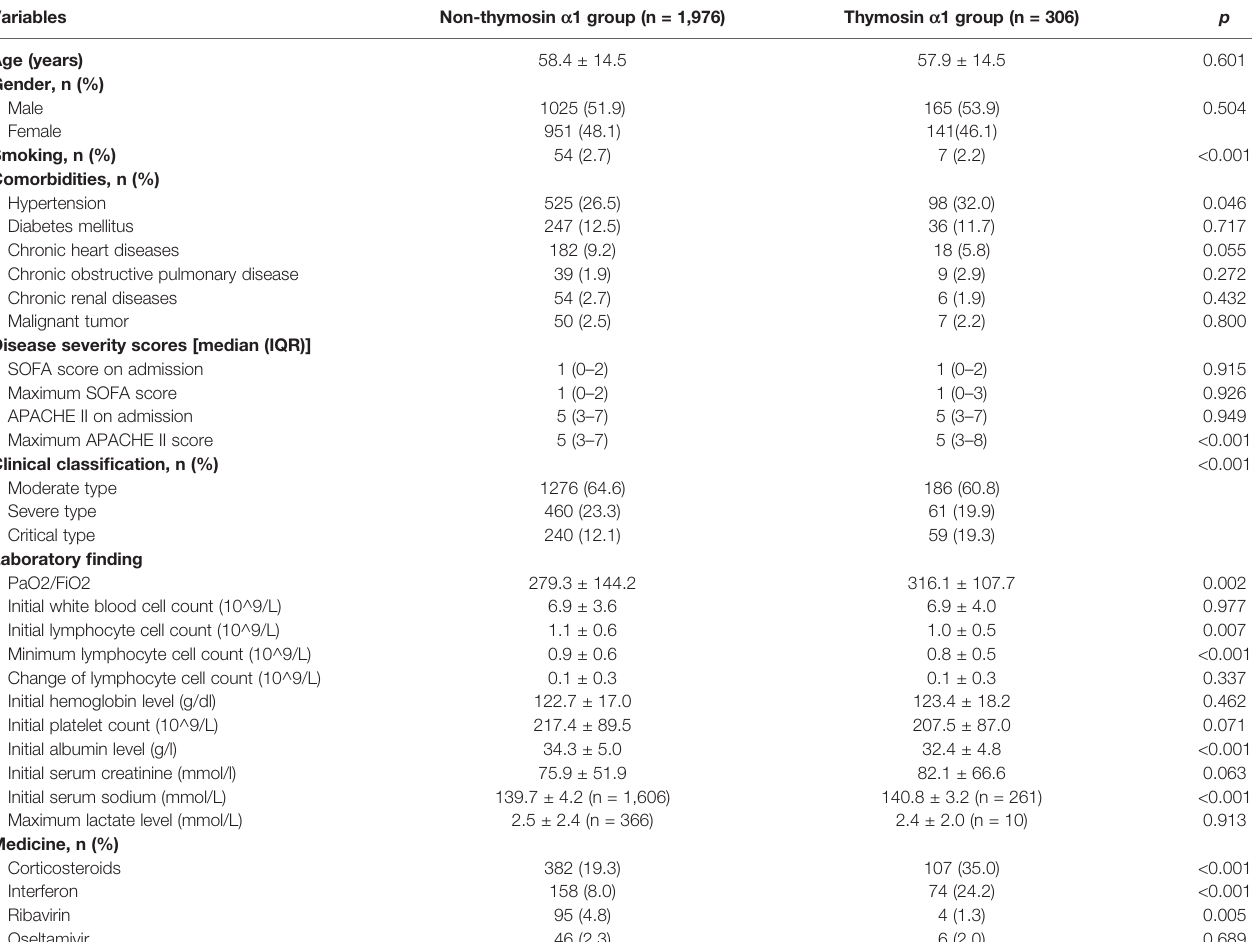
TABLE 1 | Baseline comparisons between thymosin a 1 and non-thymosin a 1 groups.